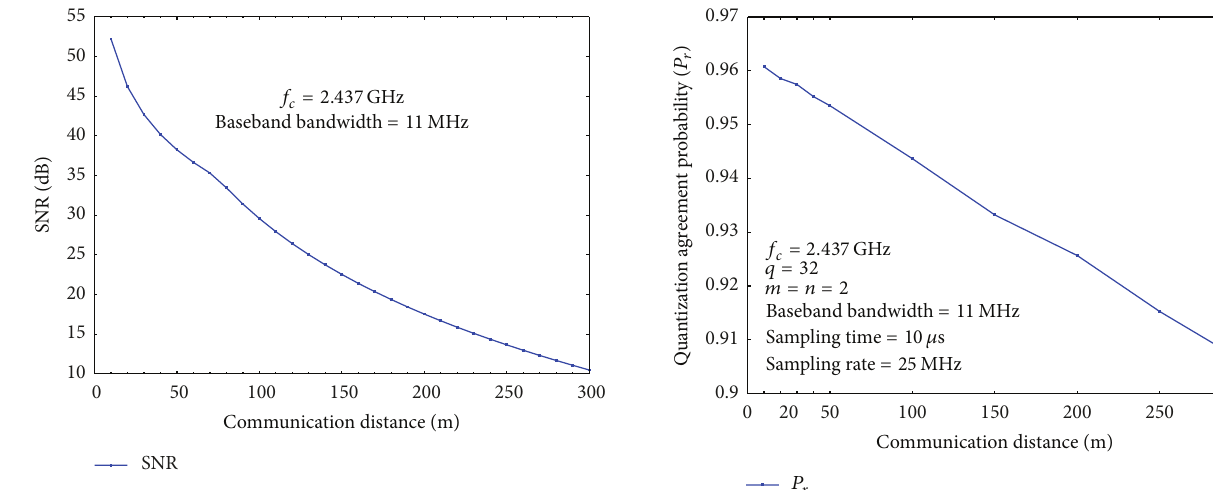
Figure 6: Quantization agreement probabilities under different communication distances.